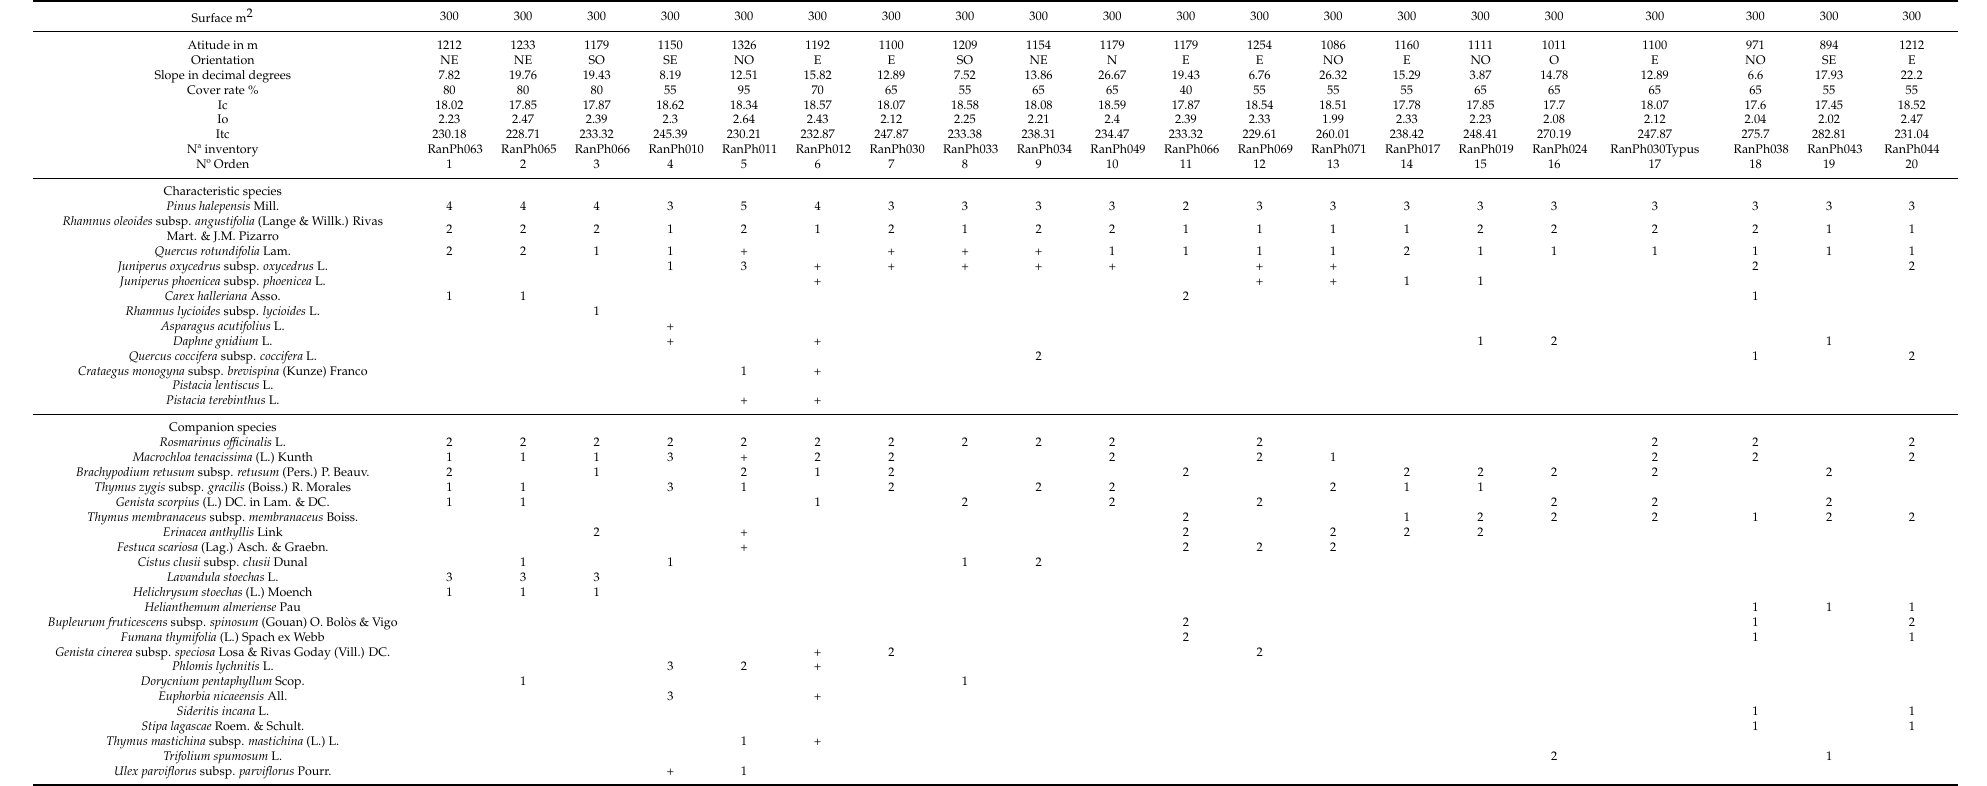
Table A3. Rhamno angustifoliae-Pinetum halepensis